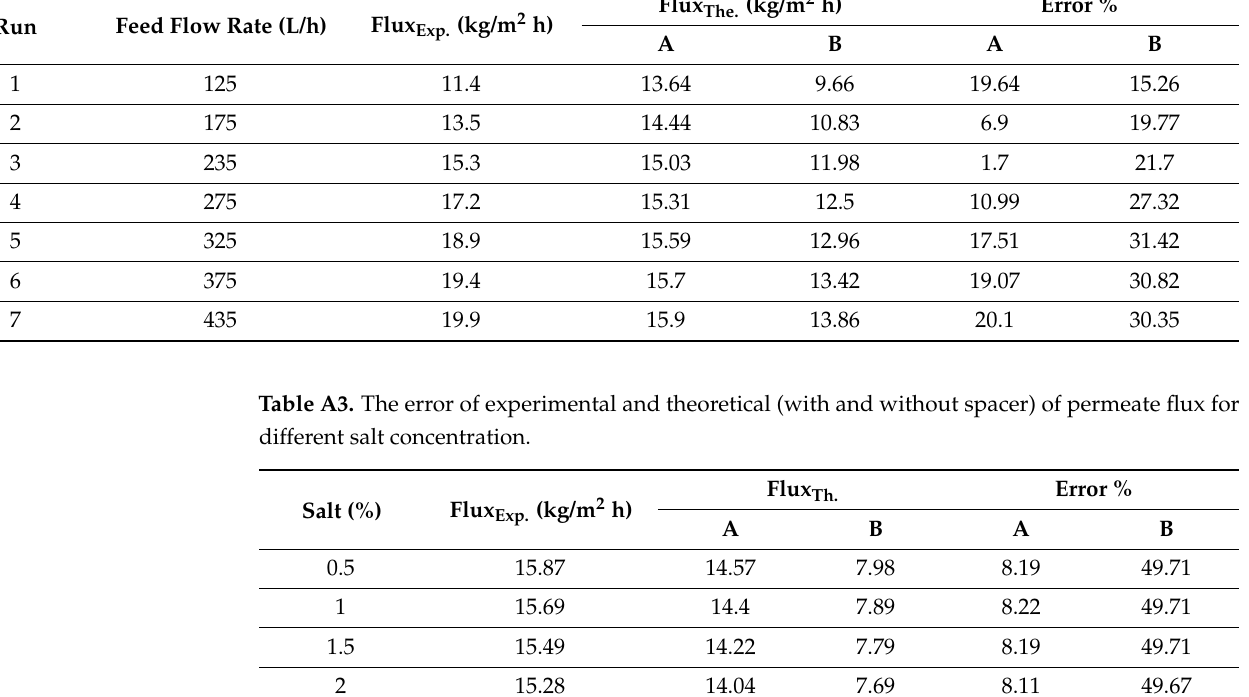
Table A2. The error of experimental and theoretical (with and without spacer) of permeate flux for different feed flow rate. Run Feed Flow Rate (L/h)